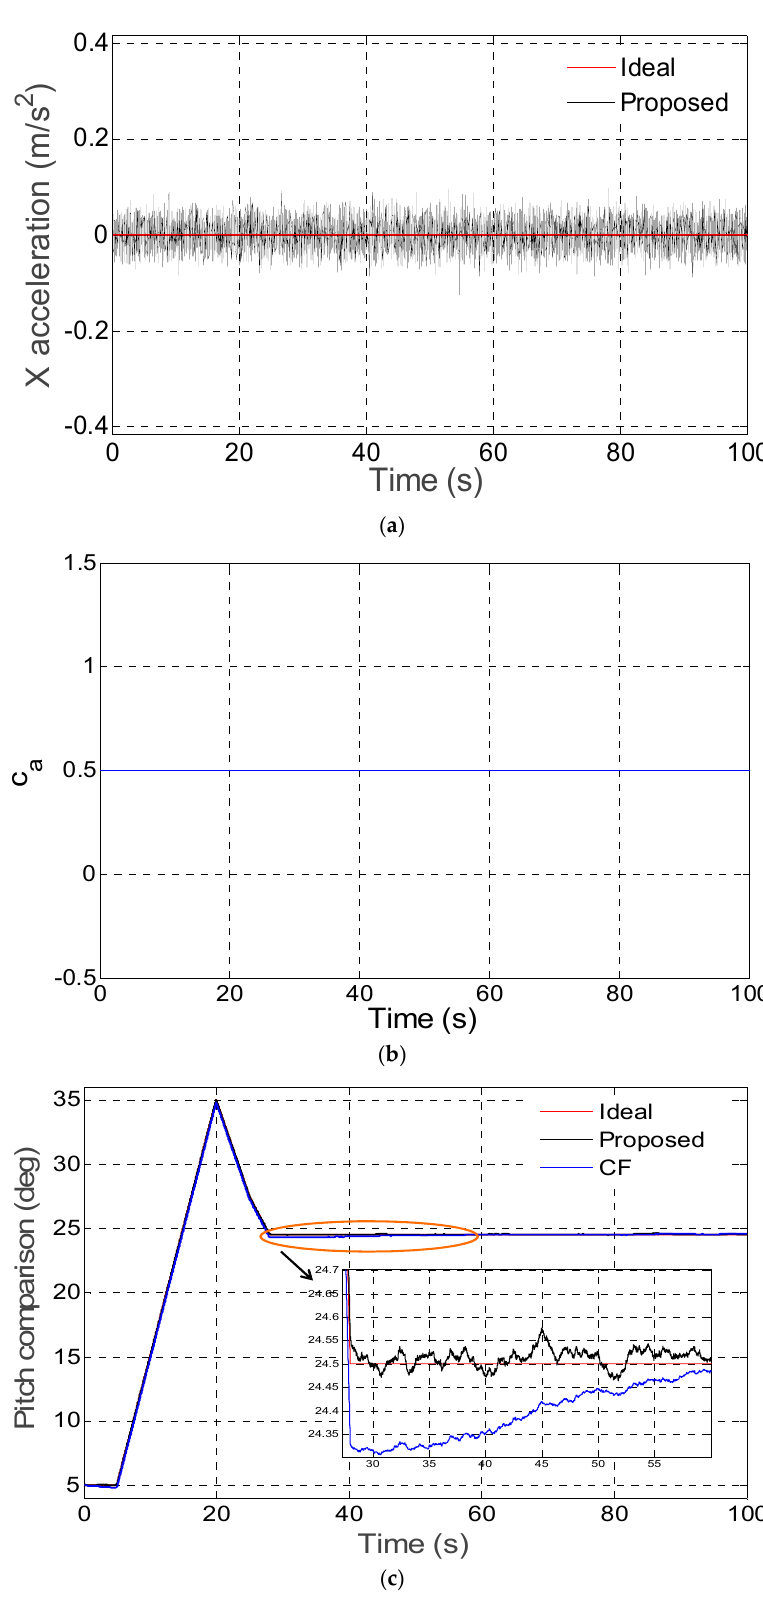
Figure 3. ( a ) X axis disturbance acceleration estimation on body frame in non-acceleration mode; ( b ) Adaptive switch for c a in non-acceleration mode; ( c ) Pitch estimate comparison in non-acceleration mode.